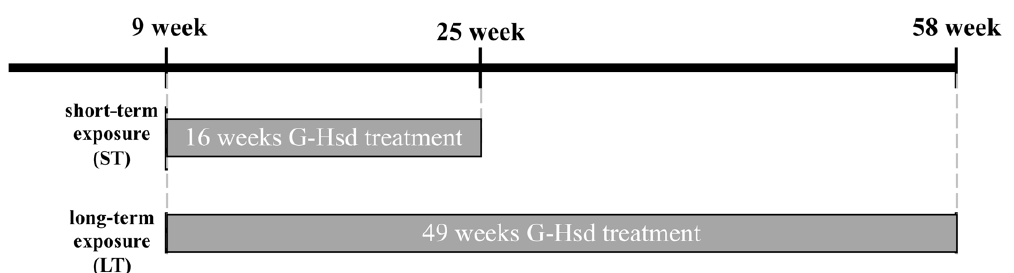
Figure 1. Experimental procedure for G-Hsd treatment. C57BL/6 mice were divided into six groups: treated with 0%, 1%, or 2% G-Hsd solution for 16 weeks (short-term exposure: ST) or 49 weeks (long-term exposure: LT) ( n = 6 to 8 mice/group).